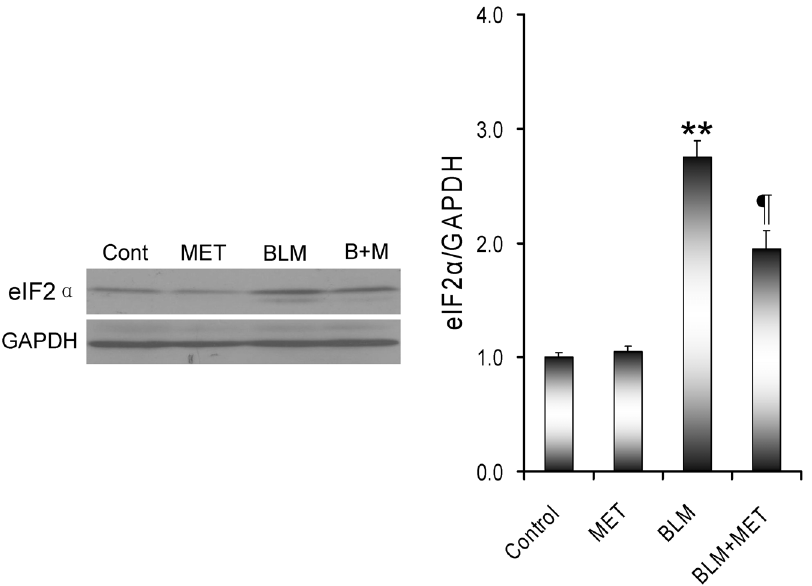
Figure 5. The effects of melatonin on BLM-induced eIF2 a phosphorylation in the lungs. All mice except controls were intratracheally injected with BLM (5.0 mg/kg). In BLM + melatonin group, mice were i.p. injected with melatonin (5 mg/kg) daily. Lungs were collected at 21 days after BLM. Pulmonary peIF2 a was detected using immunoblots. All experiments were replicated for four times. The data were expressed as means 6 SEM (n=4). ** P , 0.01 as compared with control group. ` P , 0.05 as compared with BLM